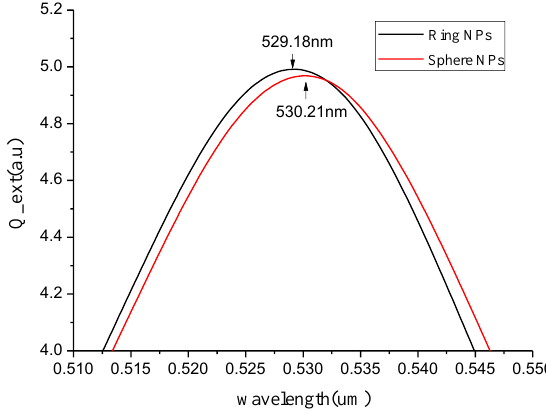
Figure 8. The absorption spectrum of ring nanoparticles and spherical nanoparticles at the wavelength of 510 – 550 nm.